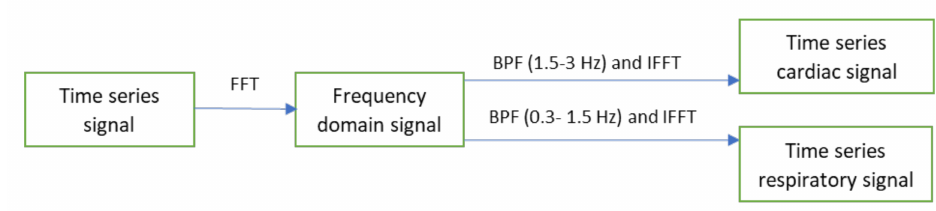
Figure 5. The spectral analysis and band-pass filtering